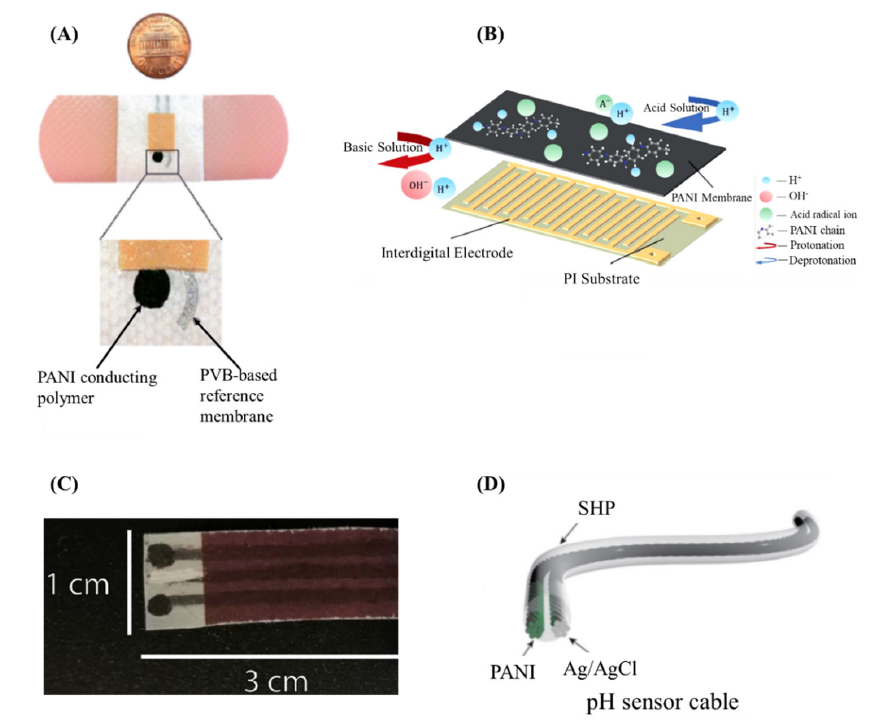
Figure 3. ( A ) PANI ‐ based pH sensor for wound monitoring (reprinted from [54] with the permission of Wiley). ( B ) PANI ‐ based interdigitate gold electrodes onto a polyimide (PI) substrate for